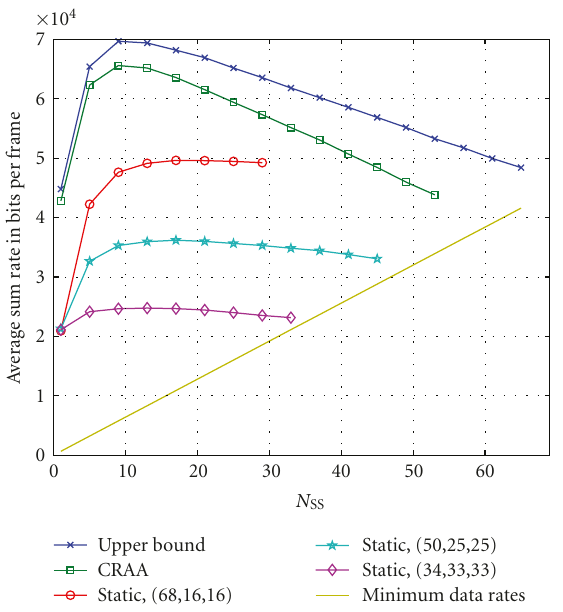
Figure 9: CDF of the data rate of the best connection assuming five SSs in a frame and a minimum data rate of 640 bits per